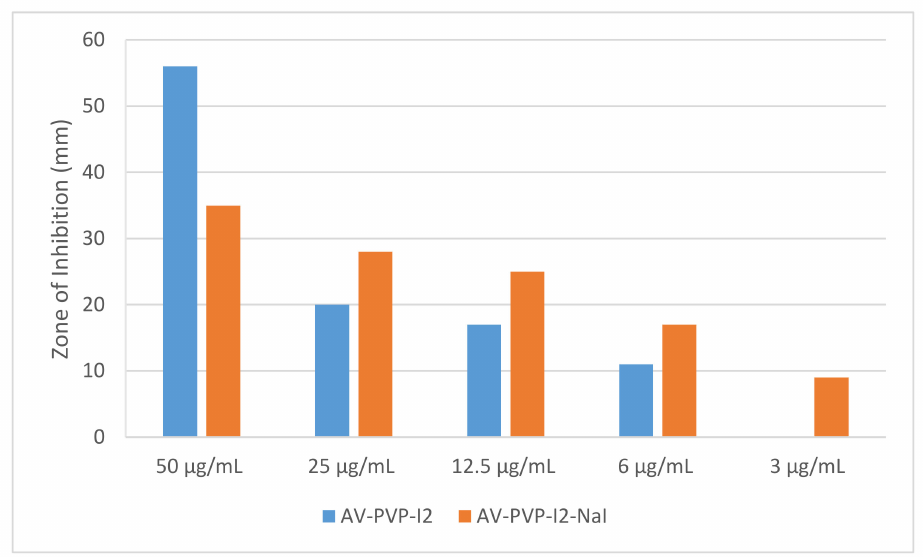
Figure 11. Antimicrobial disc di ff usion assay of the biomaterials AV-PVP-I 2 (blue) and AV-PVP-I 2 -NaI (orange) against C. albicans WDCM 00054 at di ff erent